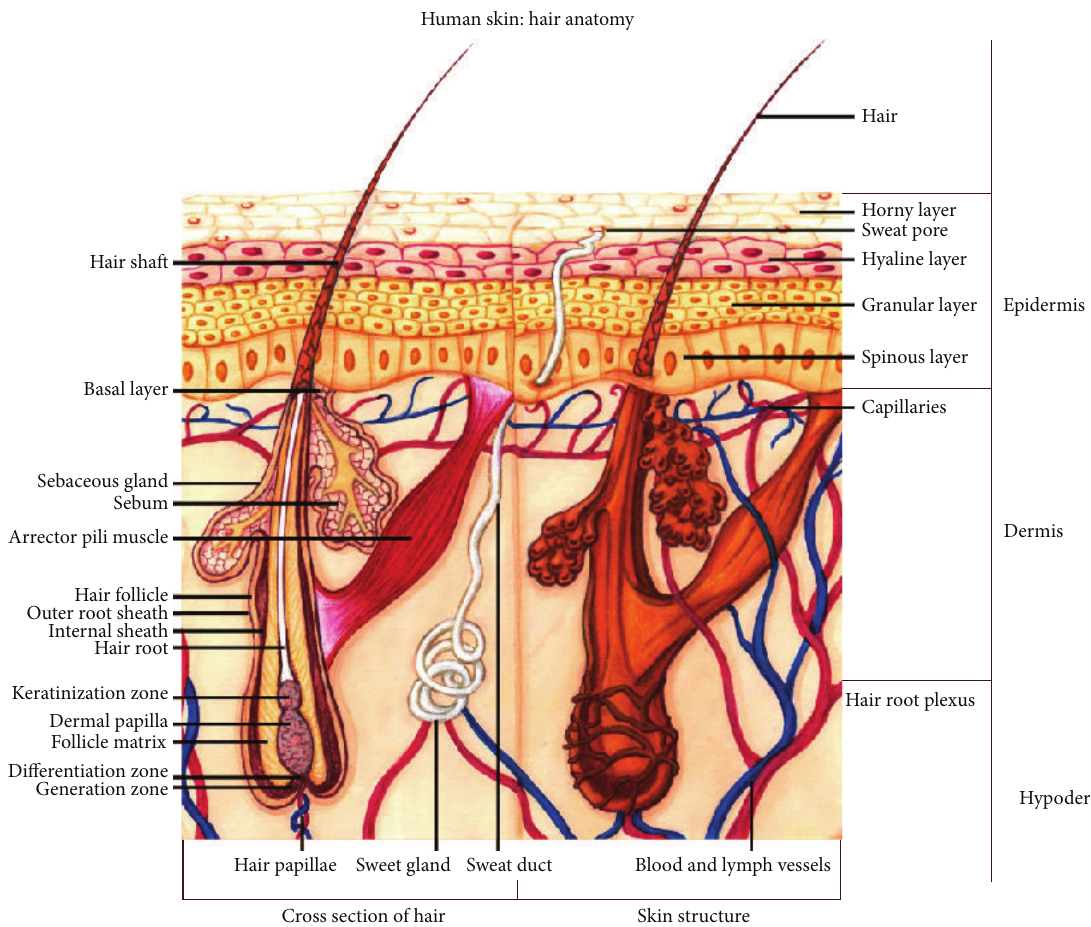
Figure 1: Graphic representation of a typical hair follicle, depicting the regions allowing for follicle generation and differentiation, together with the dermal papilla and follicle